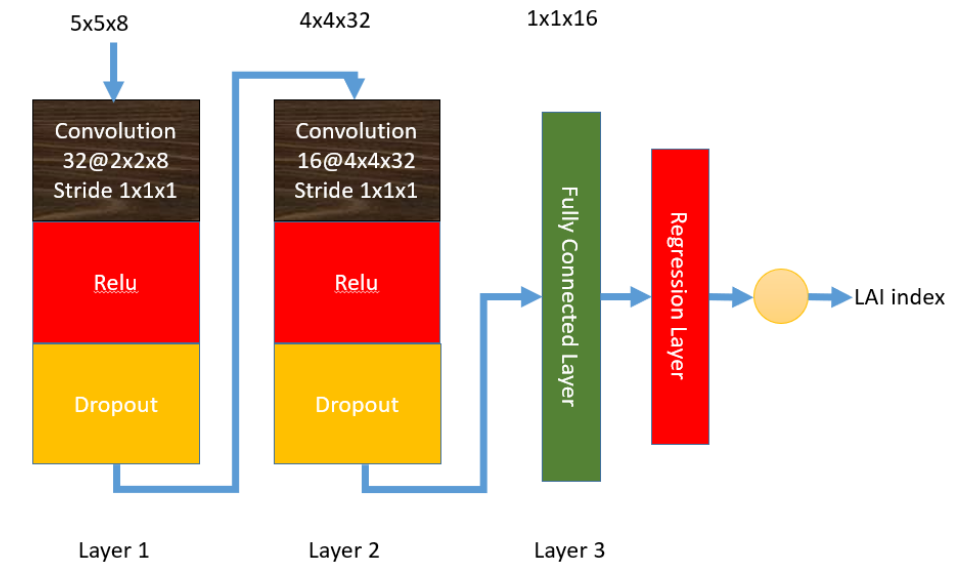
Figure 4. CNN structure for LAI regression using 8-channel pan-sharpened multispectral